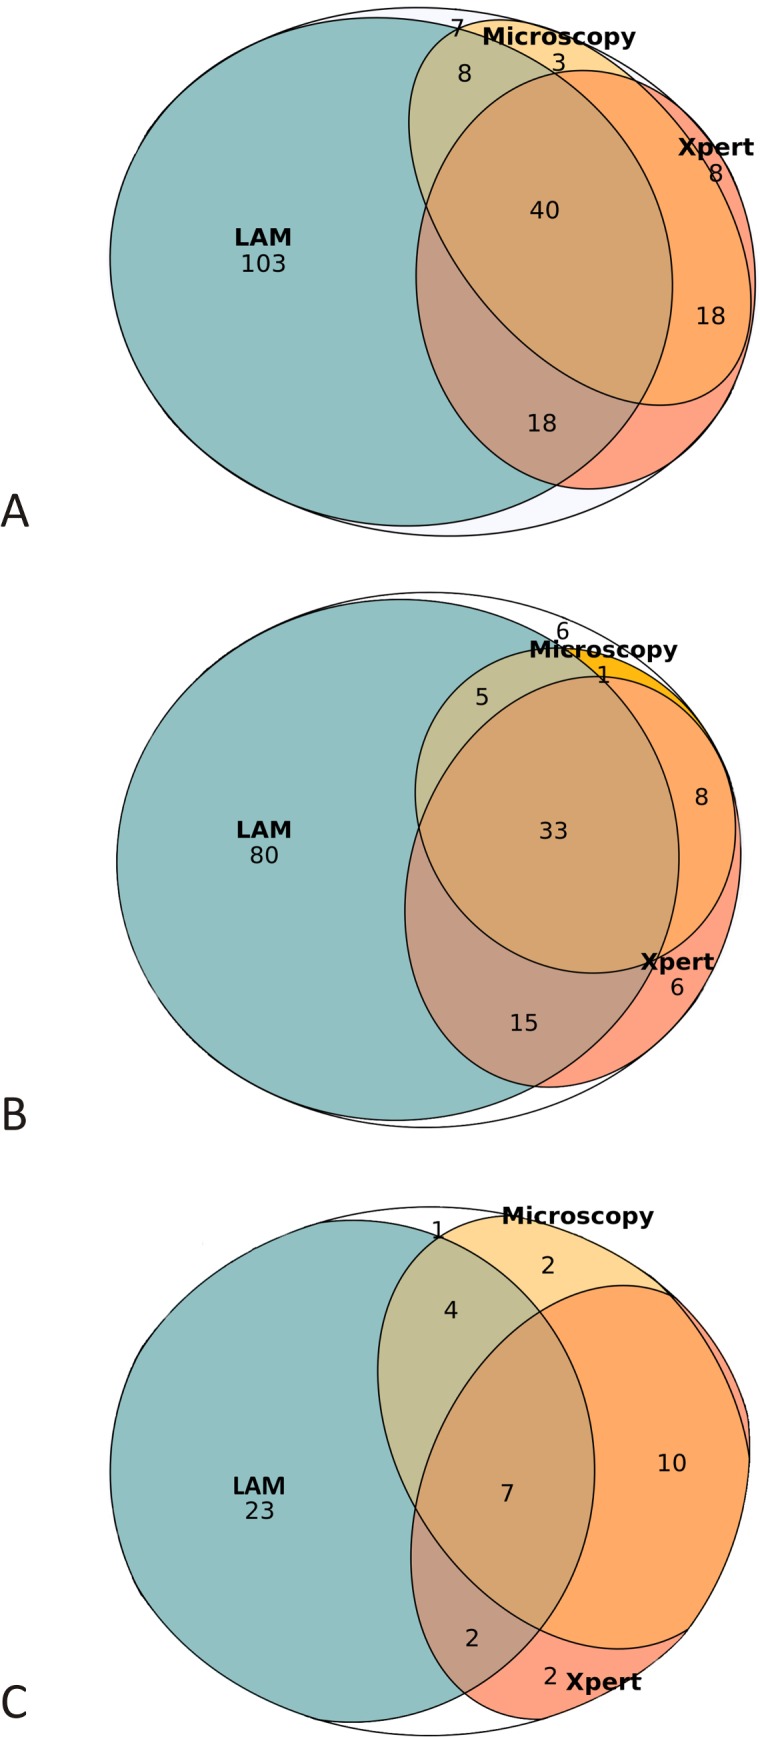
Laboratory-confirmed TB patients who would be diagnosed using LAM, microscopy, and Xpert.Euler diagrams showing the number of patients who would be diagnosed through LAM, microscopy, and Xpert among all laboratory-confirmed TB patients (A) and among laboratory-confirmed TB patients with CD4 < 100 cells/μl (B) and with CD4 100–199 cells/μl (C). Blank spaces show patients diagnosed solely with culture on sputum. The diagnostic yields of LAM, microscopy, and Xpert are shown in Table 2. LAM, lipoarabinomannan assay; TB, tuberculosis; Xpert, Xpert MTB/RIF assay.